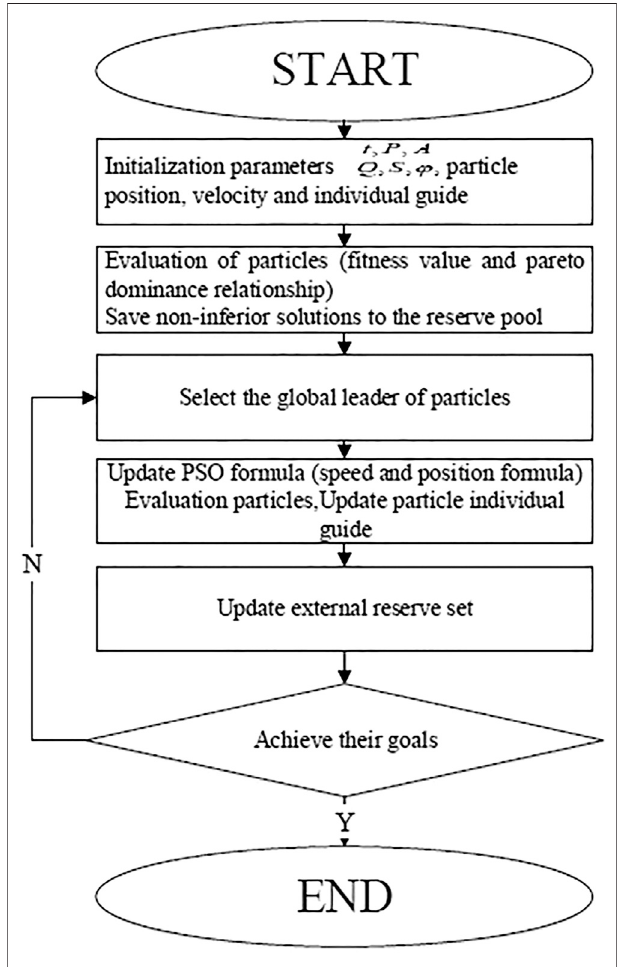
FIGURE6| Blockdiagramofmulti-objectiveparticleswarmoptimization optimization.